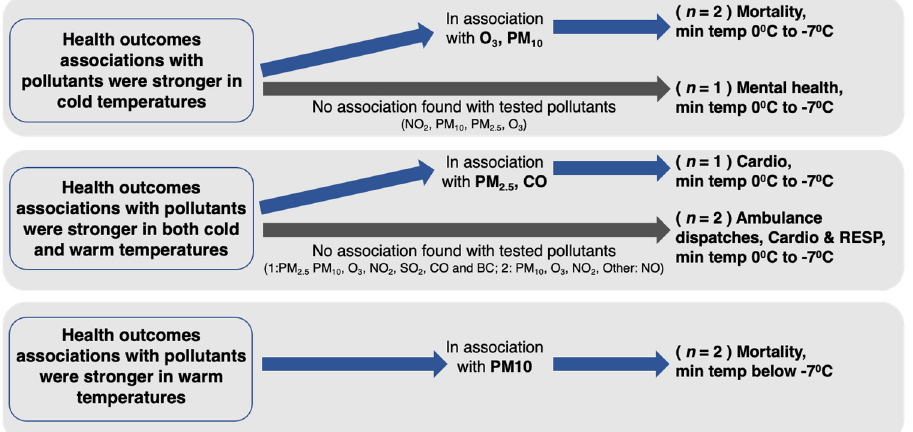
Figure 4. Eight studies tested the temperature and air pollution with health outcomes. Blue arrow = association with tested pollutants black arrow = no association with tested pollutants (cardio = cardiovascular effects, RESP = respiratory disease); warm weather refers to temperatures between 23.3–40.6 °C.